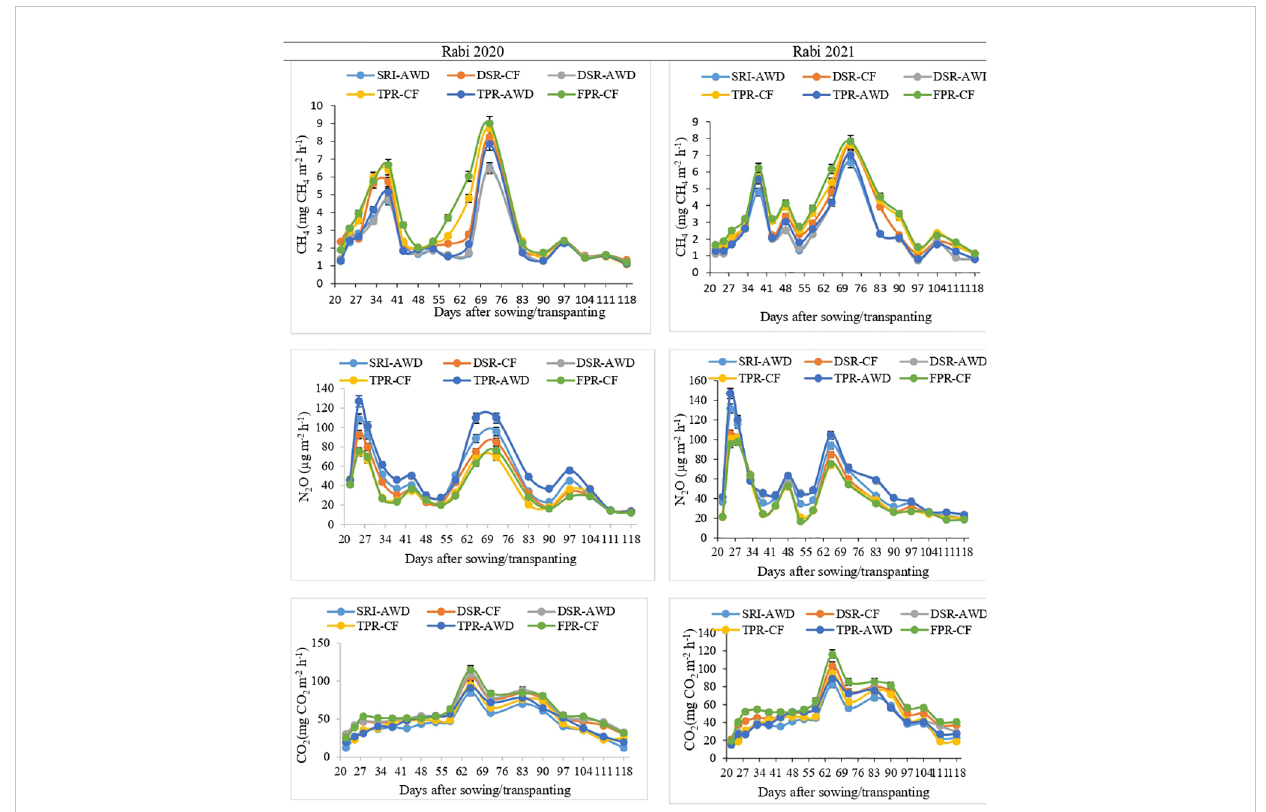
FIGURE 2 Methane (CH 4 ), nitrous oxide (N 2 O), and carbon dioxide (CO 2 ) fl ux from soils during different rice production technique of rice